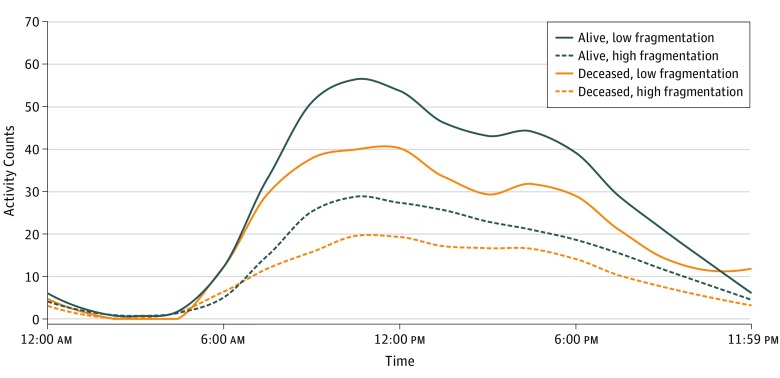
Mean Activity Patterns Stratified by Mortality and Physical Activity FragmentationGraph depicts activity counts (unitless quantities of movement collected through accelerometers) over time. Participants who remained alive accumulated higher amounts of physical activity compared with participants who died during the course of the study. However, participants with highly fragmented physical activity had compromised diurnal activity patterns, mostly notably seen among the participants who died. Physical activity fragmentation was dichotomized at the sample median of 26%. The mean (SD) fragmentation was 21% (3%) for 255 participants who were alive and had low fragmentation, 32% (4%) for 232 participants who were alive and had high fragmentation, 23% (3%) for 19 participants who were deceased and had low fragmentation, and 35% (7%) for 42 participants who were deceased and had high fragmentation.